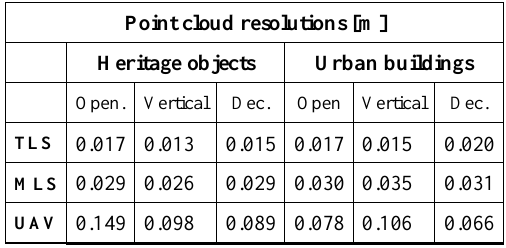
Table 1 . Point clouds average resolutions from the compared datasets (TLS, MLS, UAV) on Heritage and urban spatial qualities (openings, vertical surfaces, decorative apparatuses).